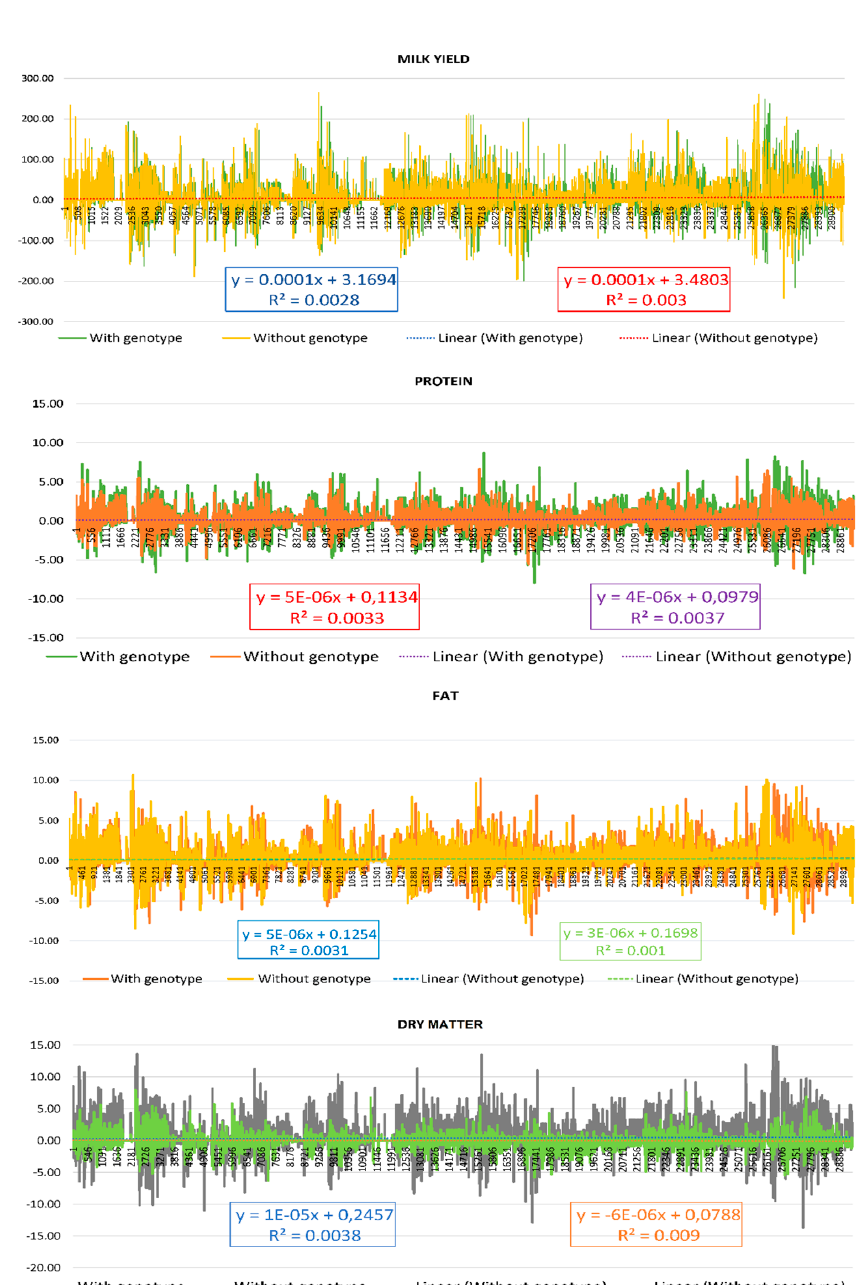
Figure 1. Comparison of predicted breeding values for milk yield or performance, protein, fat and dry matter content in kg, determination coefficients (R 2 ) and linear regression equations for their trends obtained using both a model involving the α S1- casein genotype and one excluding it for all the animals included in the pedigree ( n = 29,397) of Murciano Granadina goat breed.